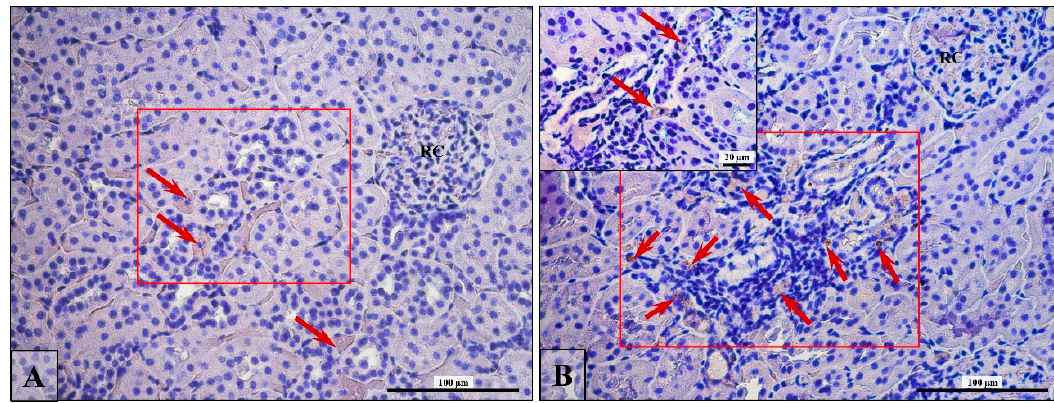
Figure 5. The representative microphotography showing IL-6 expression in control (A) and finasteride-treated (B) groups of rats. Red arrows indicate a positive area of immunoreactivity, red frames shown the areas with intense immunoreactivity for IL-6. Scale bars for A and B are 100 µm; scale bar in insertion in B is 20 µm. Two types of collagen fibers were identified by a polarized microscope, in bright yellow / orange (type I collagen) and green (type III collagen) (Figures 6 and 7).